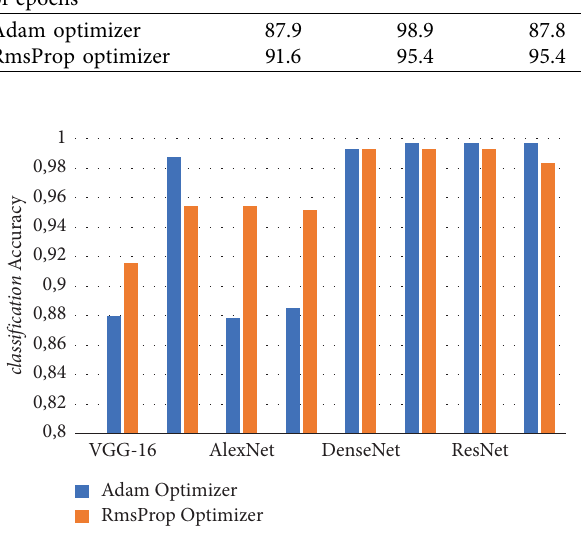
Figure 5: Accuracy of diferent networks using Adam and RmsProp optimizer.